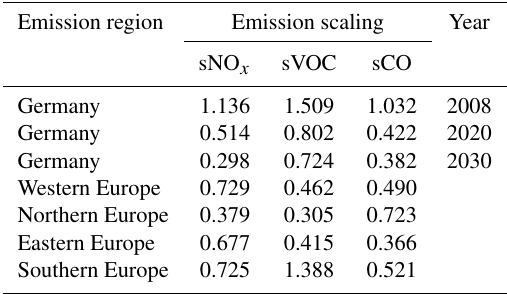
Table 4. Emission scaling factors for the TransClim simulation to reproduce the VEU1 simulations with EMAC. The emission scal- ing factors in Germany for the years 2008, 2020 and 2030 are also indicated. For the remaining European regions, the emission scal- ing factors are set constant for the years 2008, 2020 and 2030. The scaling factors of the remaining emission regions are not listed in the table as they are kept at